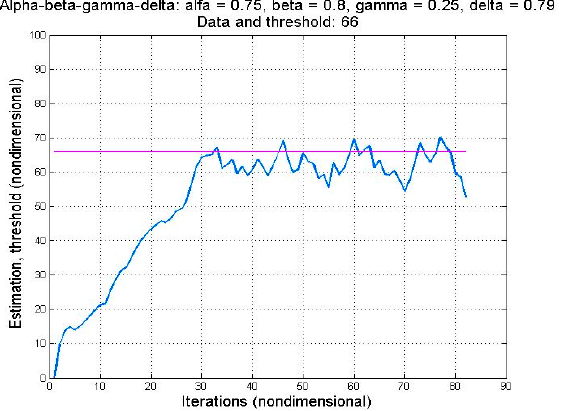
Figure 13. The α – β – γ – δ filter succeeds in sidestepping the threshold value of 66.